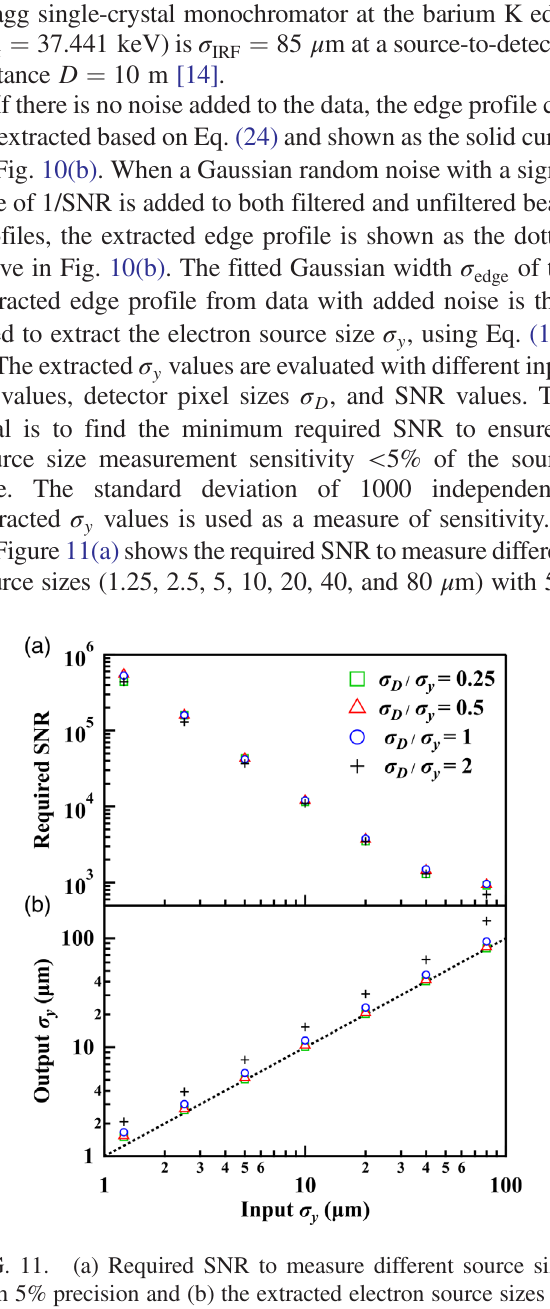
and detector pixel sizes σ y